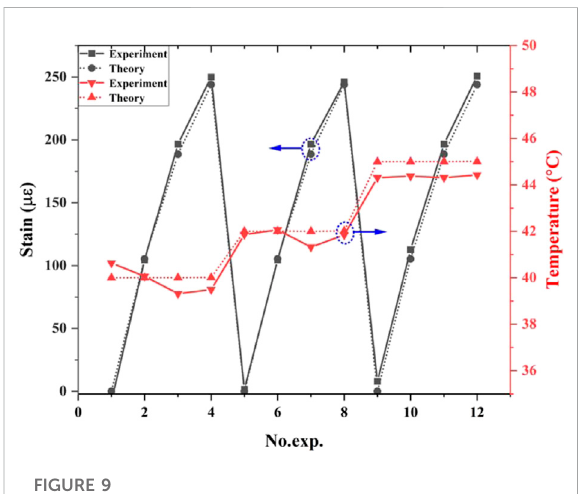
FIGURE 9 Comparison of theoretical (dashed lines) and experimental data (solid lines) curves for strain and temperature